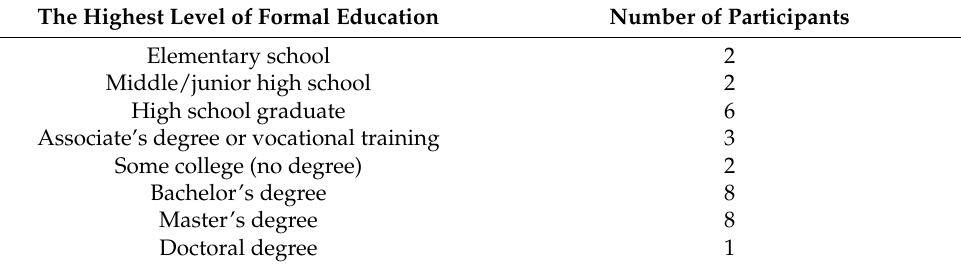
Table 2. Participants’ education